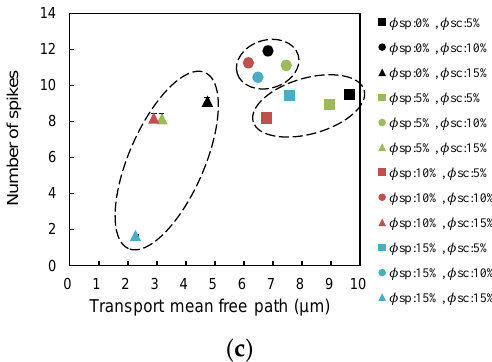
Figure 7. ( a ) Maximum peak intensity, ( b ) spike height, and ( c ) the number of spikes in the emission spectrum versus the TMFP. Each dashed ellipse represents a group of scattering particles having the same volume fraction. The different colors represent the different volume fractions of SPs. The pumping energy and the energy density are 13 µJ and 22.8 µJ/mm 2 , respectively. The error bars represent the standard errors.